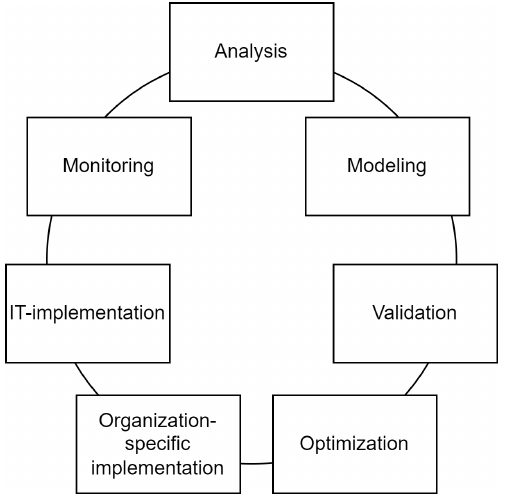
Figure 3. Open Control Cycle of S-BPM Activity Bundles, reprinted from (Ref. [23], p.31)